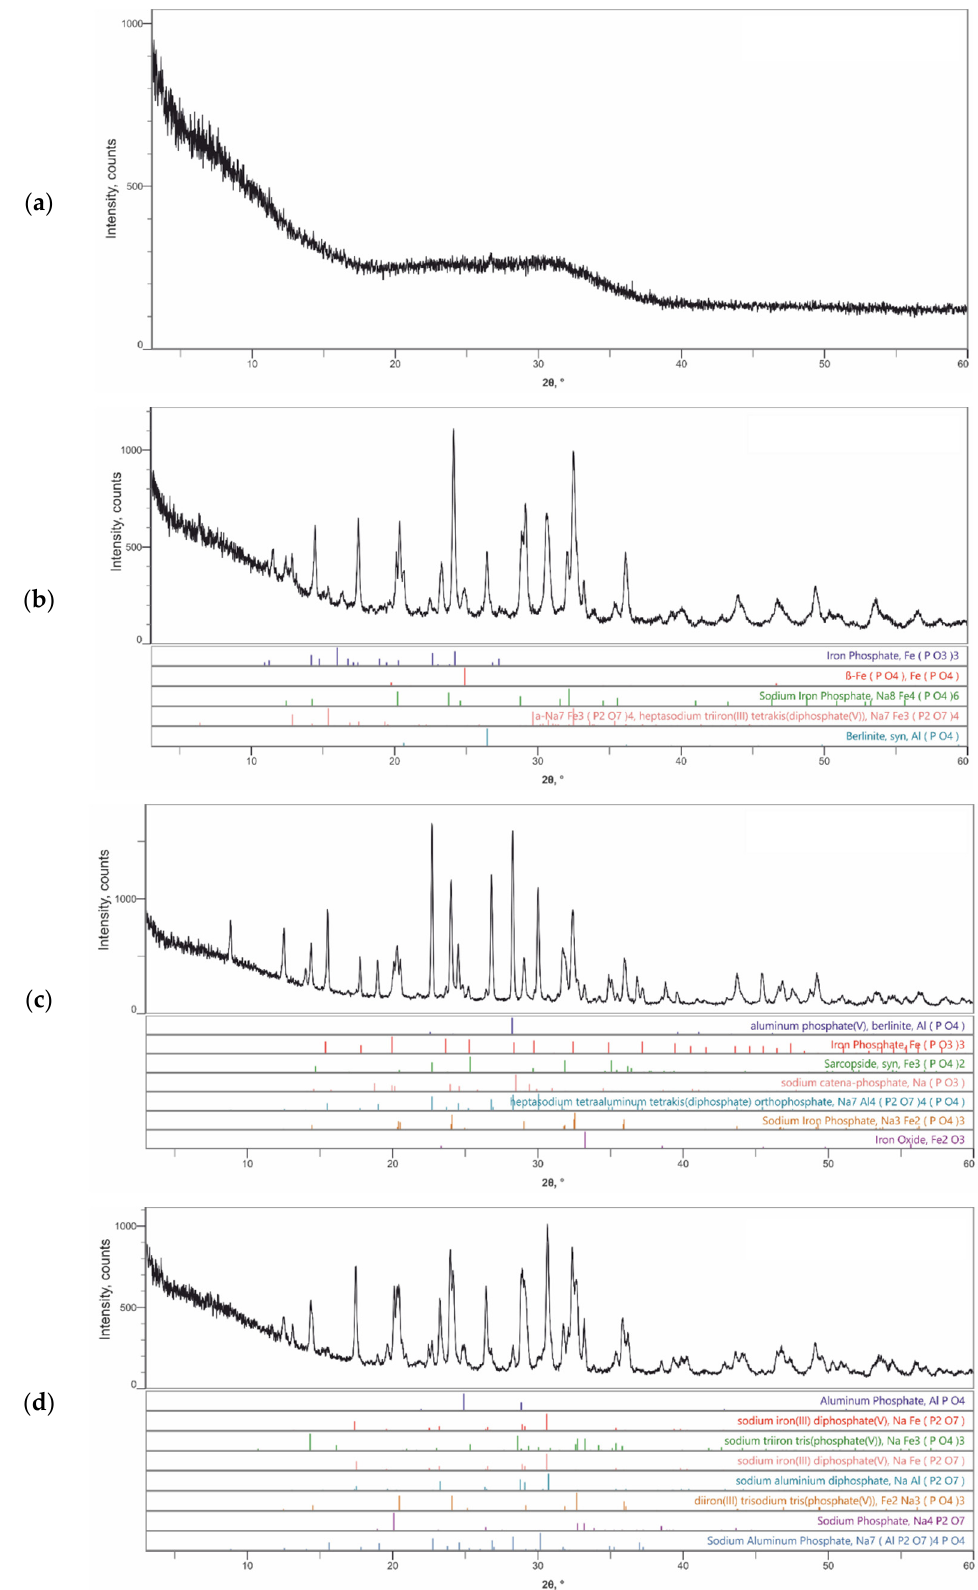
Figure 3. X-ray diffraction patterns of NAFP matrix samples synthesized at 450 ( a ), 550 ( b ), 650 ( c ) and 750 °C ( d ).